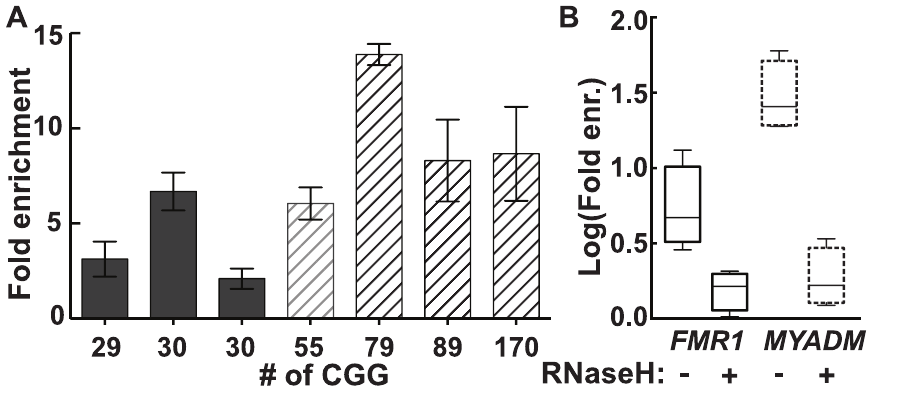
Figure 2. R-loop pull-down in human dermal fibroblasts confirms R-loop formation in the genome. ( A ) Fold enrichment for FMR1 in dermal fibroblast cells cultured from seven individuals using a monoclonal antibody specific to hybrids. Enrichment is relative to input and a non-R- loop-forming genomic reference locus. ( B ) Treatment with recombinant RNases H1 and H2 (RNase H) eliminates enrichment seen for FMR1 (solid lines) and MYADM (broken